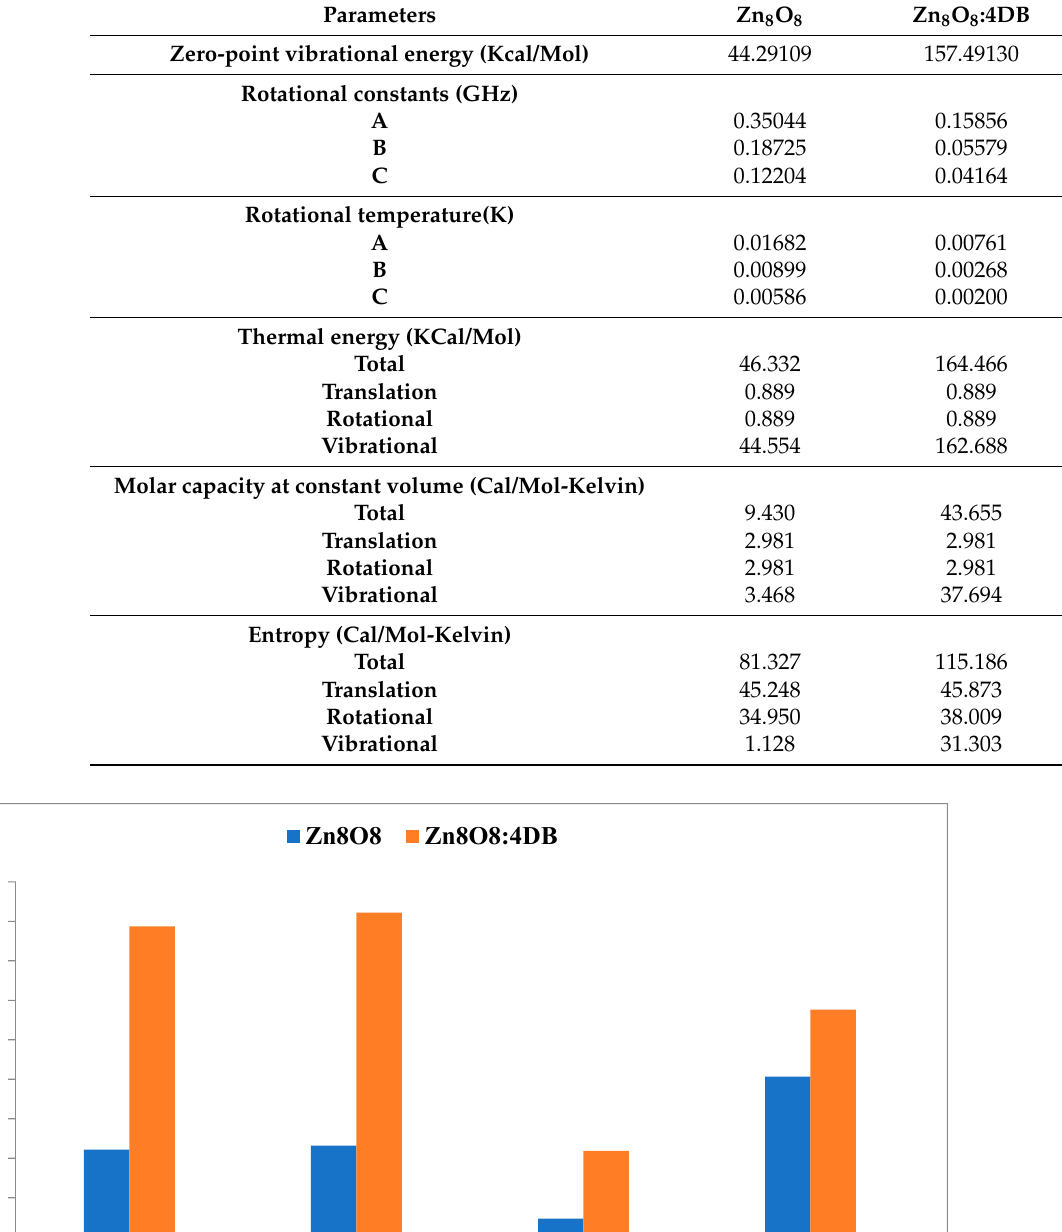
Table 5. Thermodynamic properties calculated for the Zn 8 O 8 and Zn 8 O 8 :4DB clusters using the B3LYP/6-311 G(d, p) level.